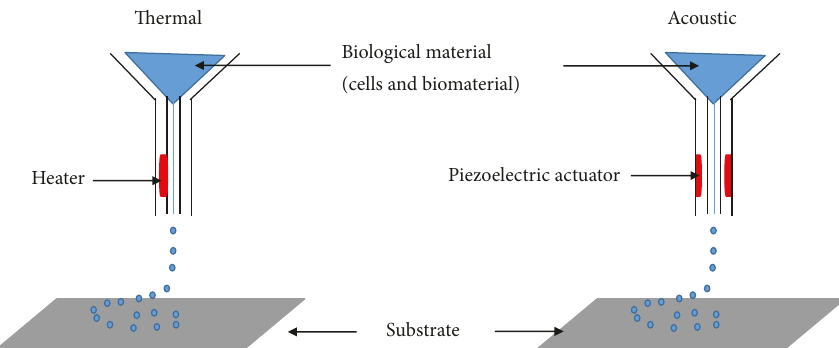
Figure 1: Inkjet bioprinting components. Thermal inkjet printers heat the print head electrically to produce pressure pulses that force droplets of biological material through a nozzle. Acoustic inkjet printers use pulses generated by piezoelectric pressure to break liquids into droplets.